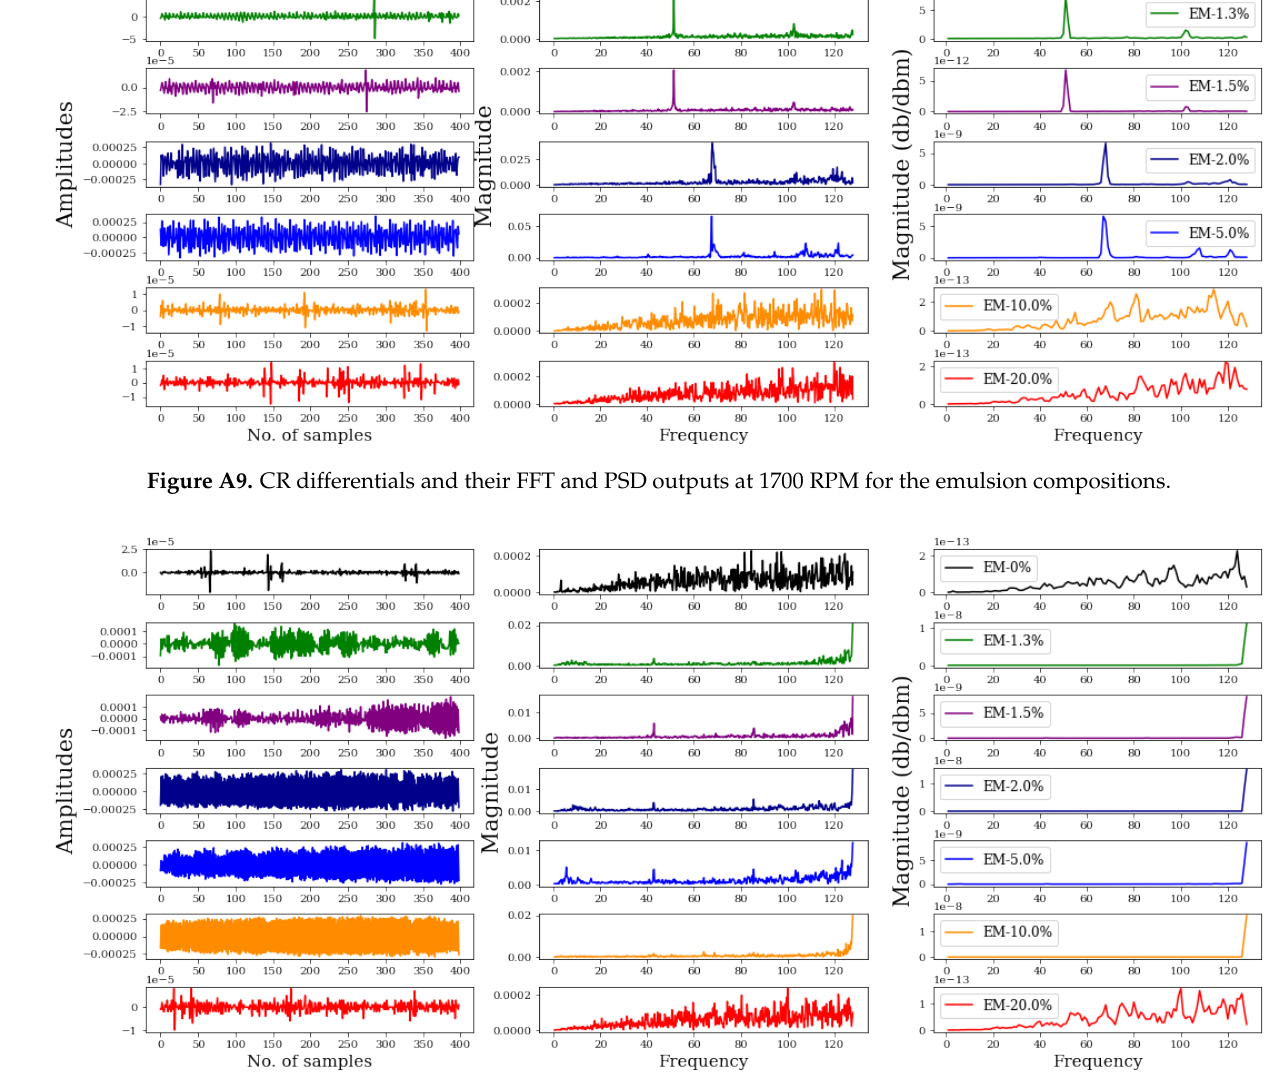
Figure A10. CR differentials and their FFT and PSD outputs at 2000 RPM for the emulsion